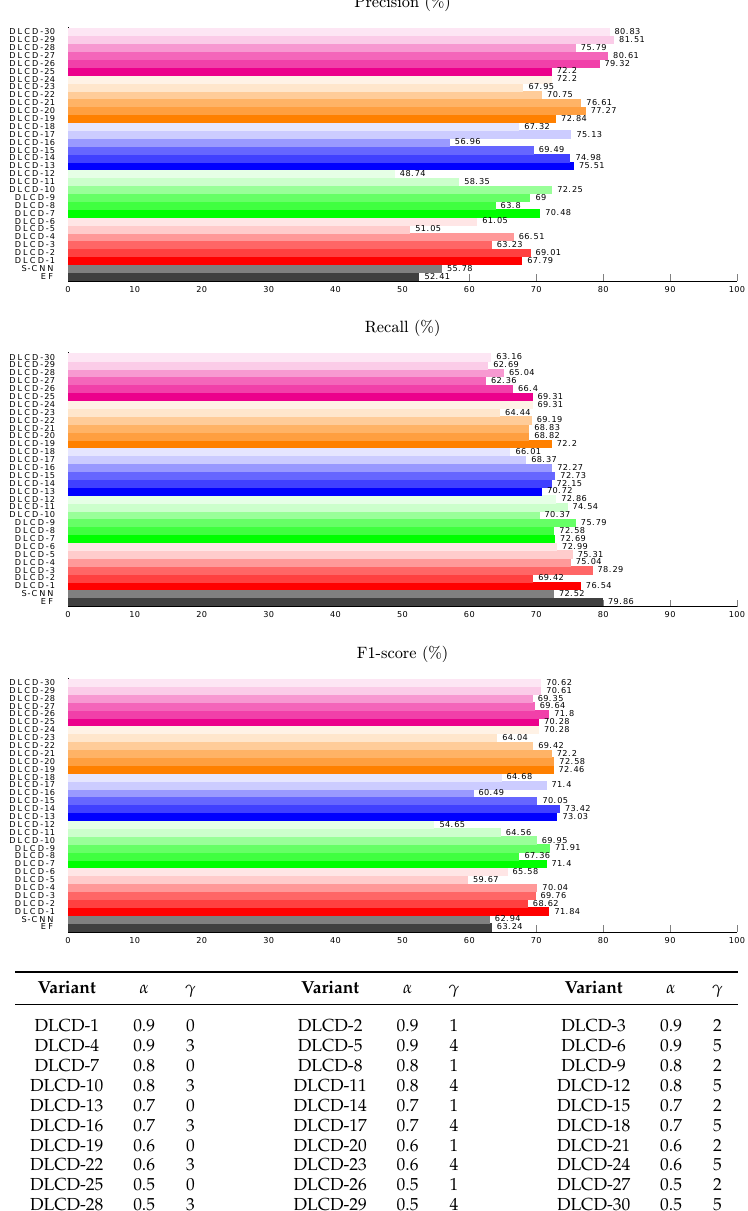
Figure 4. Precision Recall and F1-Scores obtained for distinct Weighted Focal Loss function parameters while using the four tiles training set